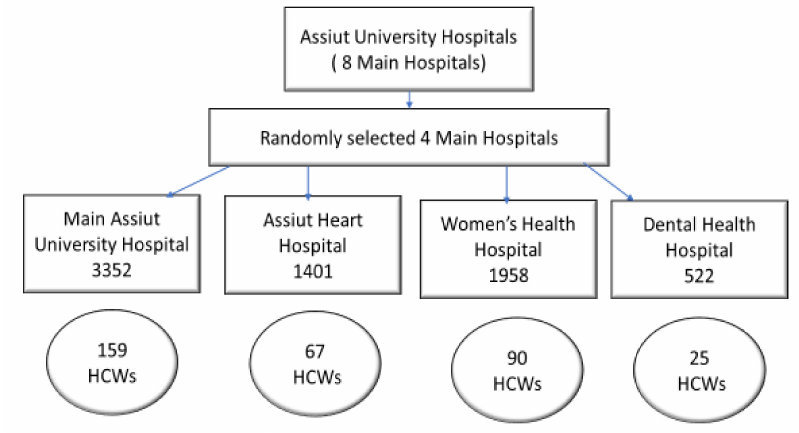
Figure 1. Flow chart of recruited healthcare workers in Assiut University